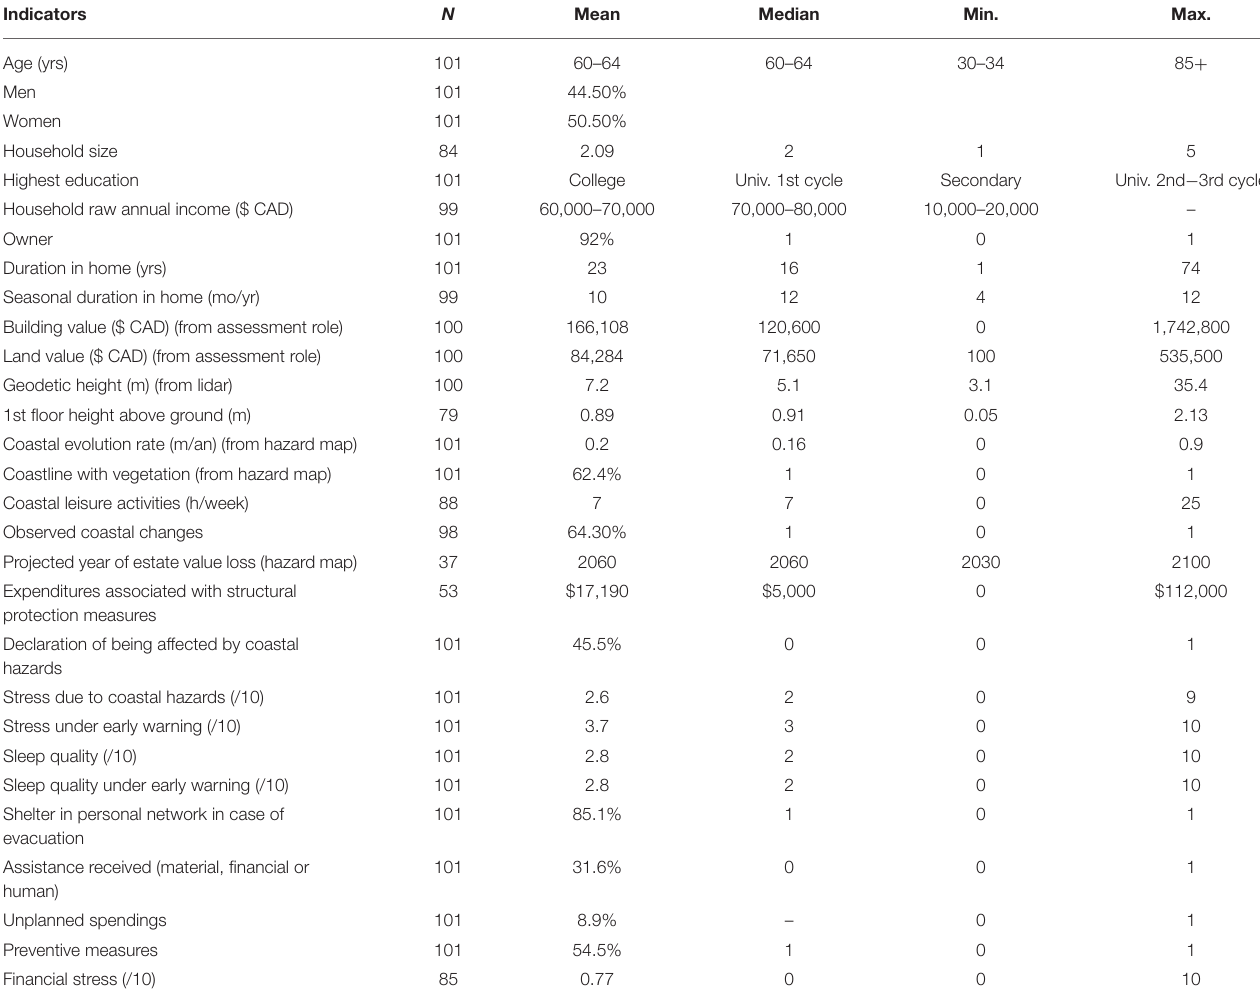
TABLE 1 | Sample descriptive statistics ( n = 101 people).